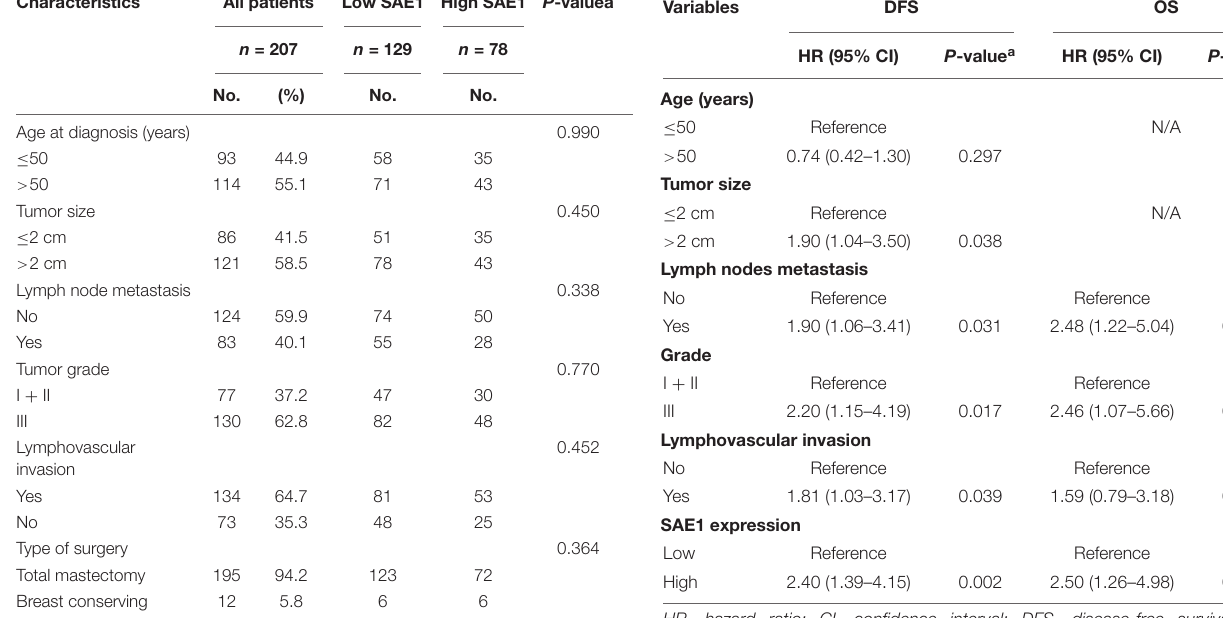
TABLE 1 | Characteristics of triple-negative breast cancer patients and their SAE1 expression level. Characteristics